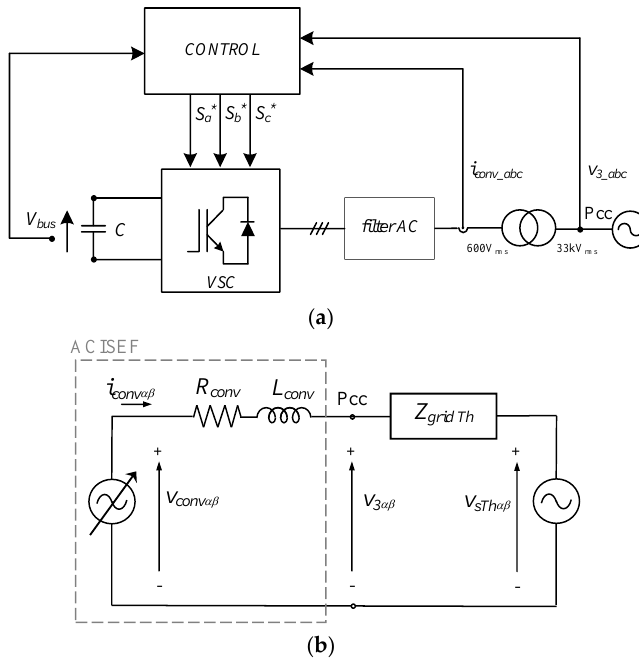
Figure 5. Converter operating as an active impedance at selective frequencies. ( a ) Power circuit structure; ( b ) simplified equivalent electric model of the AC grid and ACISEF with the application of Thevenin’s theorem.